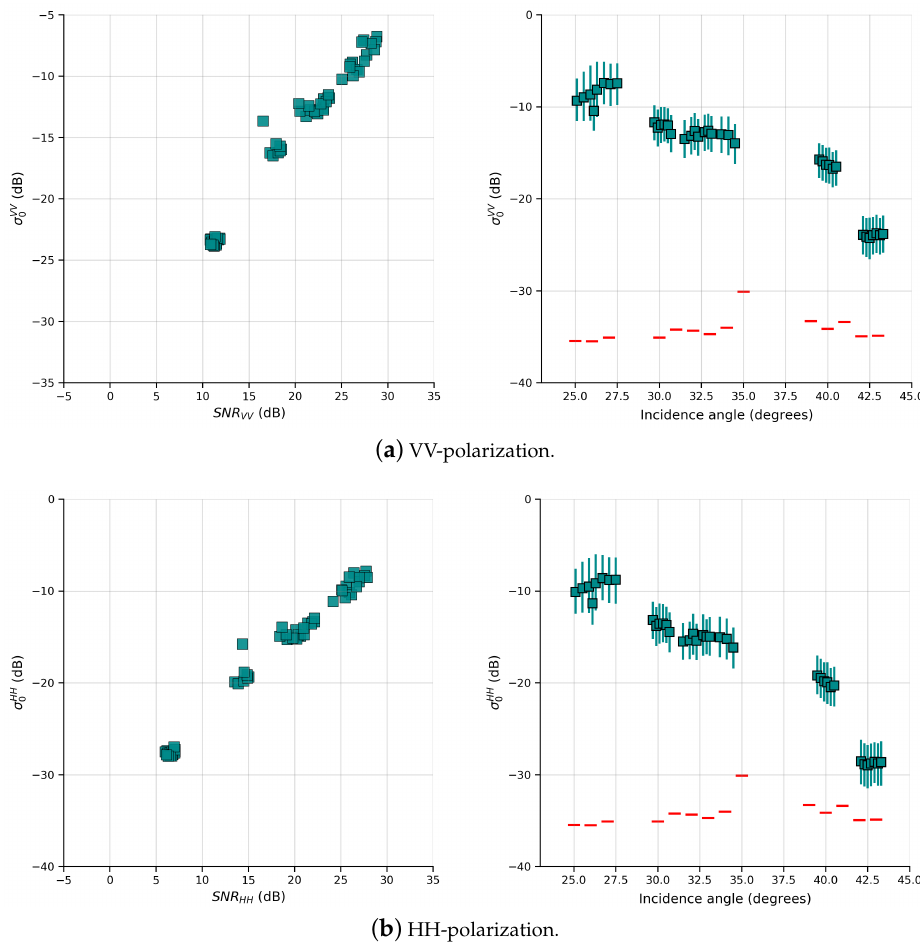
Figure 10. ( Left ) Mean σ 0 values versus the SNR in dB for VV ( a ) and HH ( b ) polarizations. ( Right ) Mean σ 0 values and percentiles of 5% and 95% versus the mean incidence angle in each ROI for VV ( a ) and HH ( b ) polarizations. Red lines represent the estimated NESZ as function of mean incidence